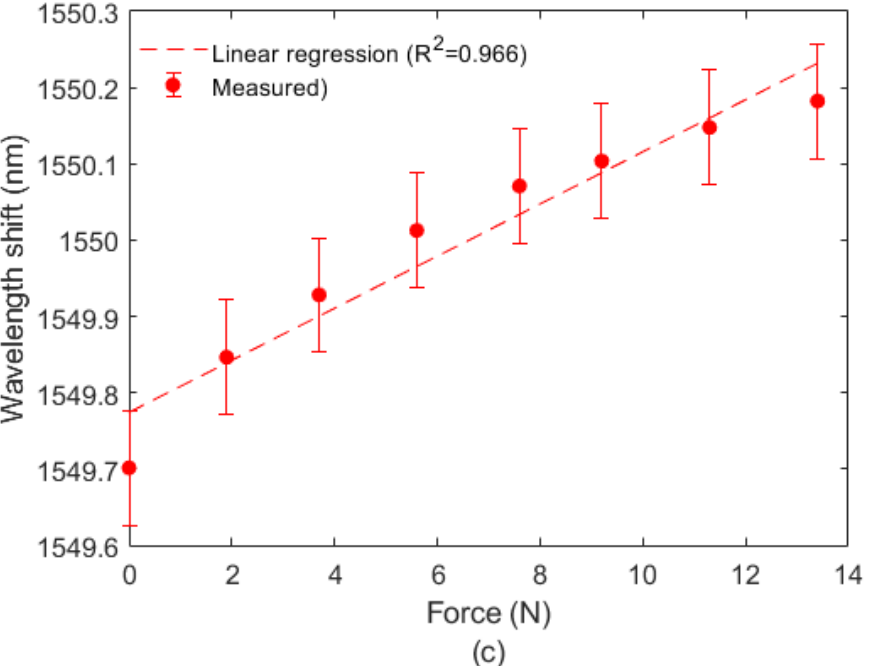
Figure 4. ( a ) FBG reflected spectra in three conditions; ( b ) wavelength shift as a function of ( b ) displacement and ( c ) force.